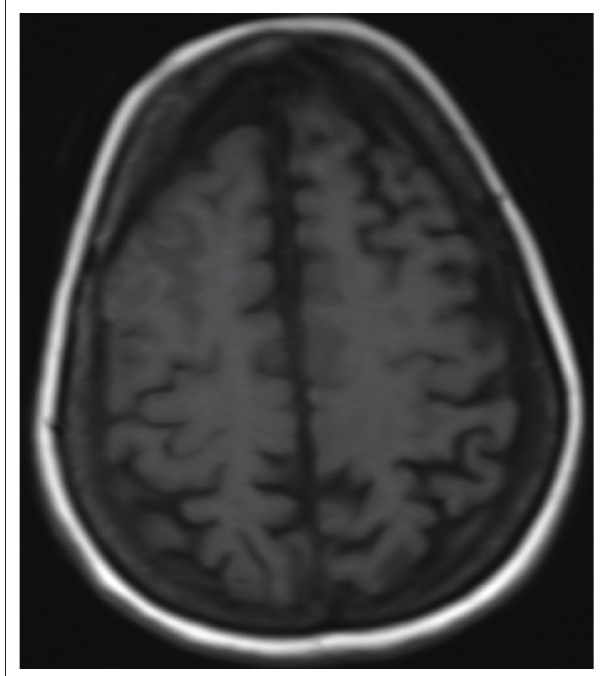
FIGURE 6: Axial T1-weighted MRI image.